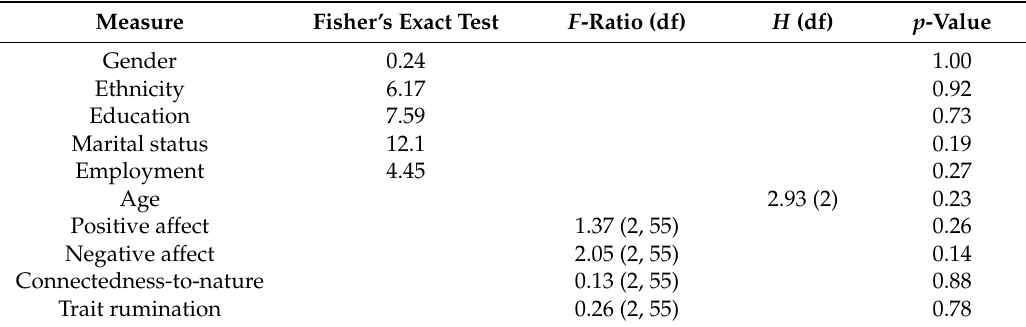
Table 3. Significance Tests for Baseline Differences Across all Variables.